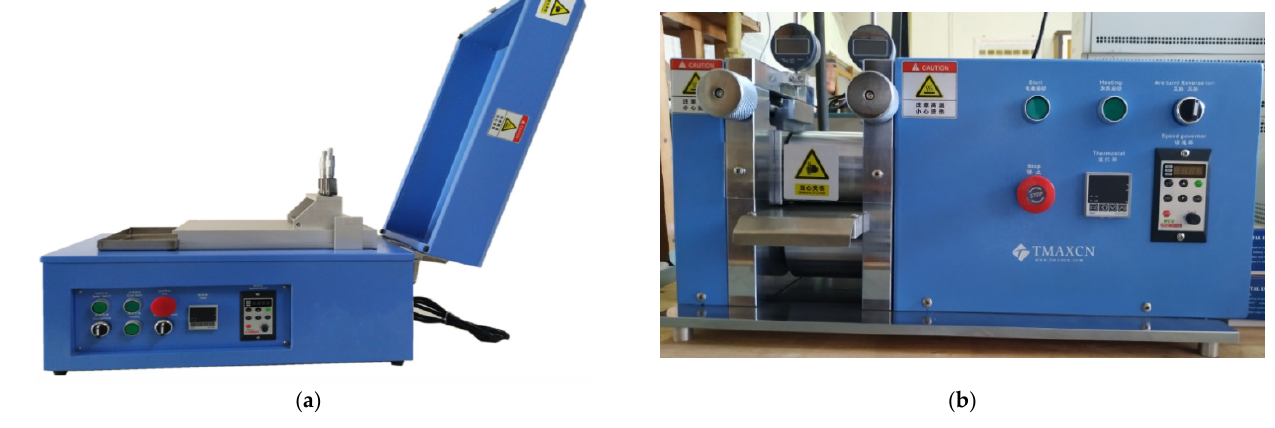
Figure 1. “Doctor Blade” device ( a ) and rolling mill ( b ).